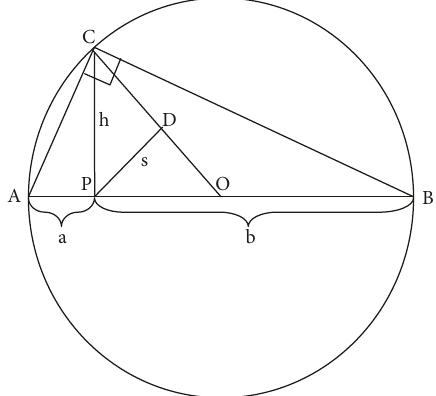
Figure 8: Schematic diagram of the tai chi theorem deduction.